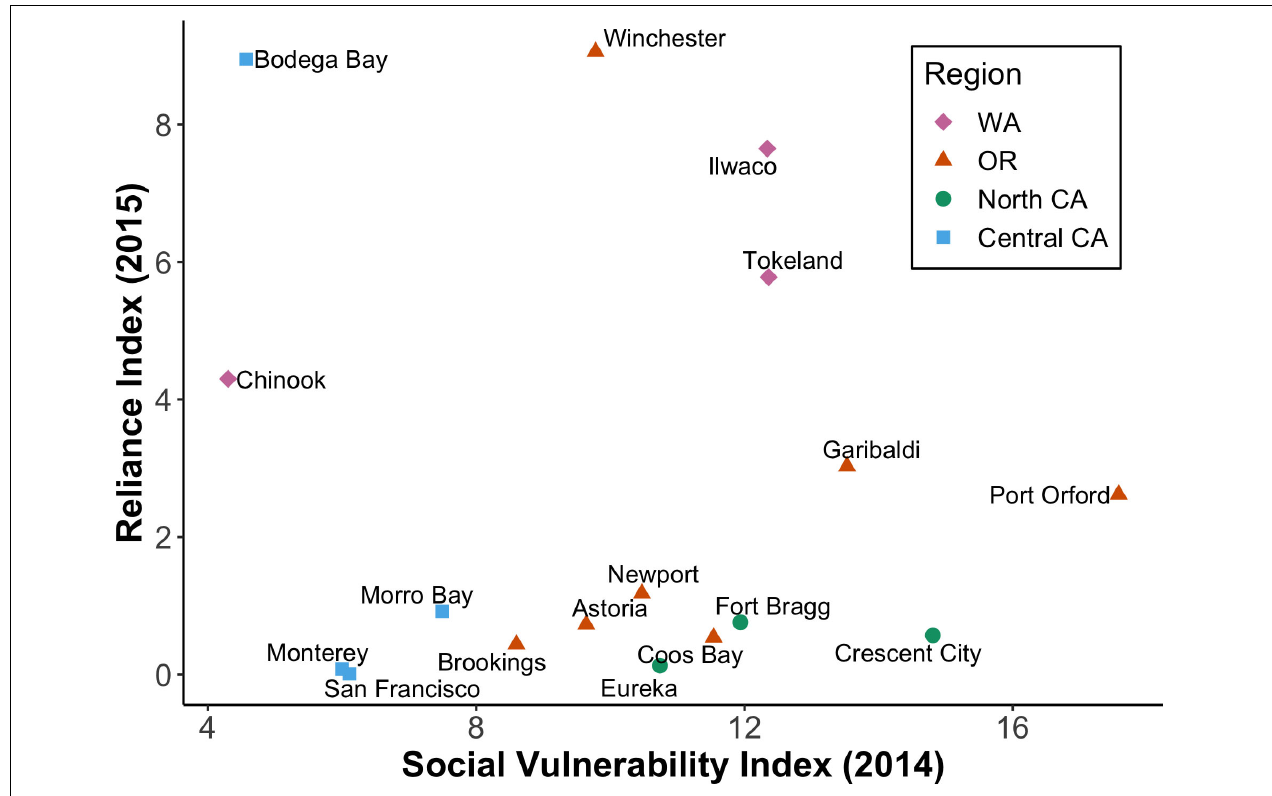
FIGURE 7 | Dungeness crab reliance index for 2015 versus social vulnerability (CSVI) for 2014. Reliance scores consider per capita engagement in the Dungeness crab fishing industry, while CSVI indicates the overall vulnerability of a community. This figure excludes Westport, WA, which had anomalously high reliance and moderate vulnerability ( Table 4